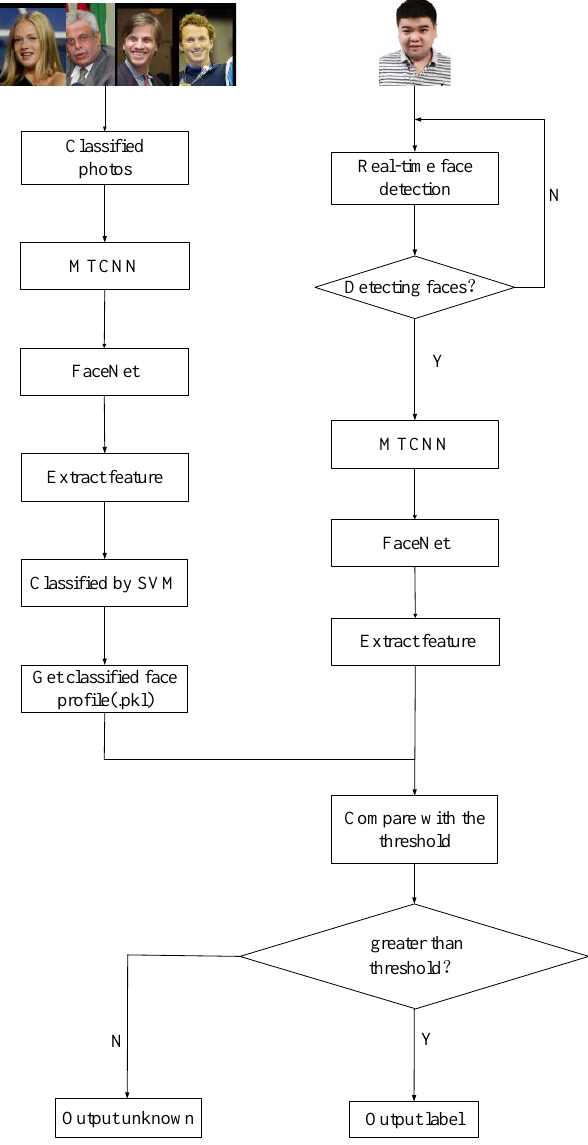
Figure 6. Face recognition process by IFaceNet. SVM.